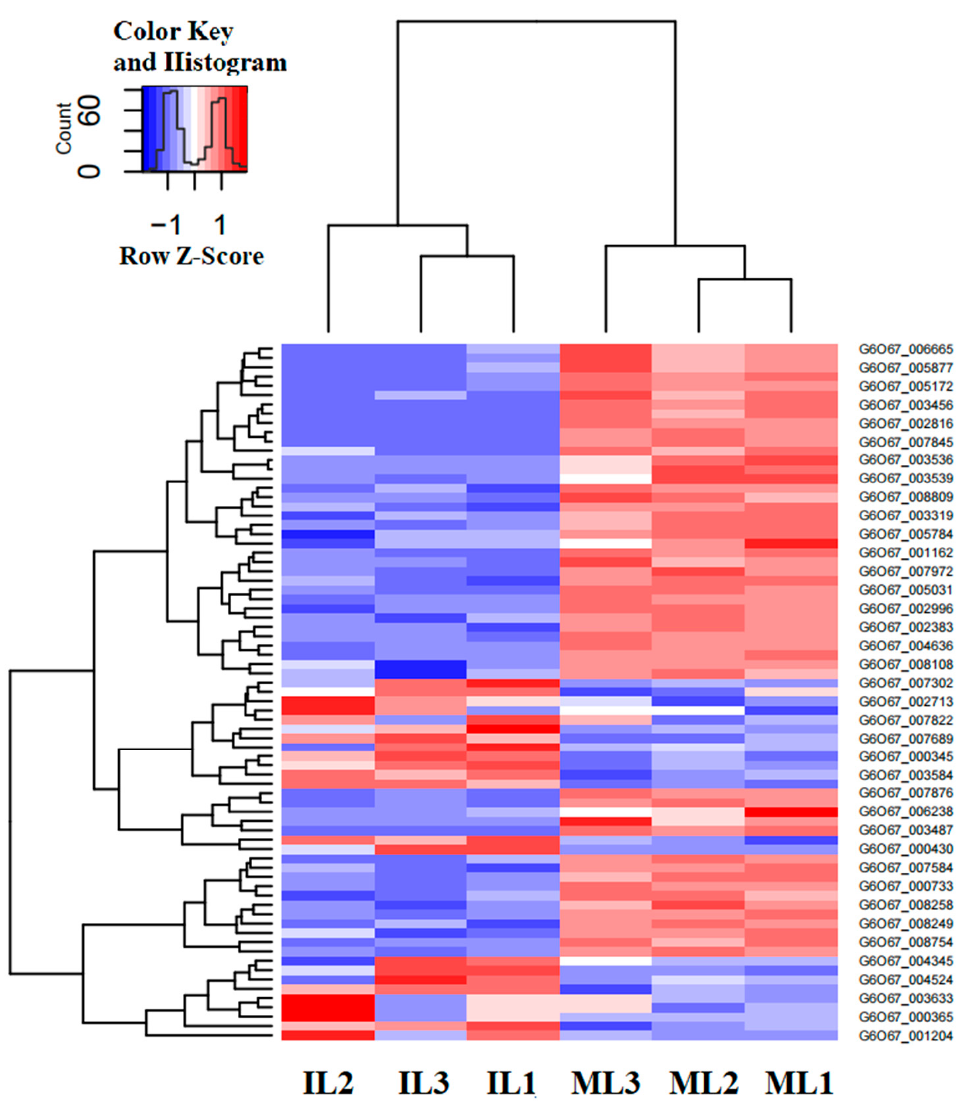
Figure 12. The heatmap of the Cluster diagram of DGEs probably involved in fungal pathogenicity in IL vs. ML. Each column represents one sample. Rows represent different genes. The expression level of genes (FPKM) was normalized by log2 and presents as different colors based on scale bar. IL represents the one-year post-infected larva of H. xiaojinensis by O. sinensis . ML represents the mummified larva of H. xiaojinensis.